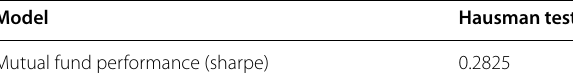
Table 2 Summary of joint F -test statistical results. Source : calculated by the author